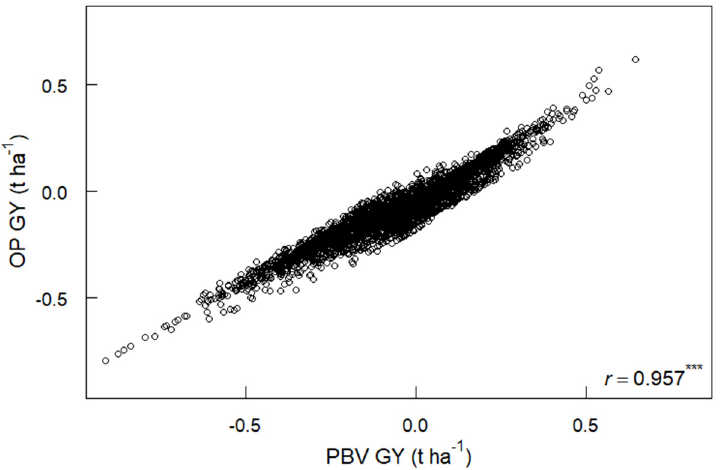
Figure 7. Correlation of overall performance for grain yield (OP GY, t ha − 1 ) and predicted breeding values for GY (PBV GY, t ha − 1 ) across genotypes from the optimum MMM-FA model (see Table 2). *** p < 0.001.